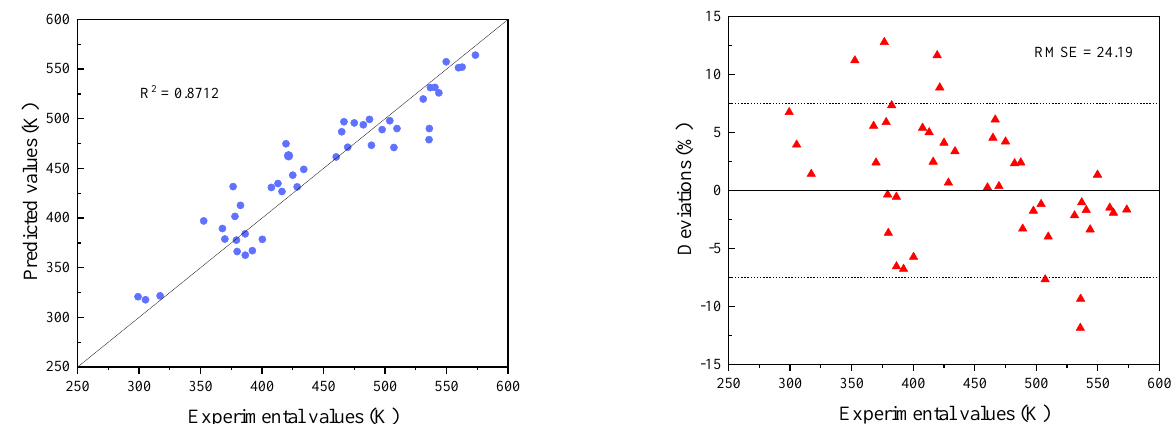
Figure 3. Predictive performance of MLP + Pubchem model.